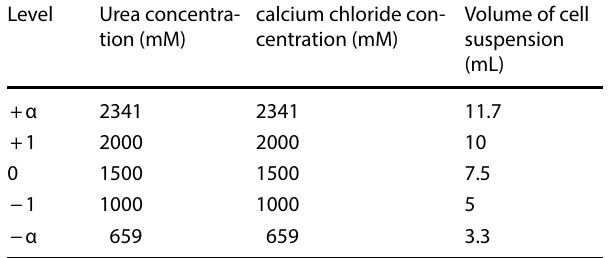
Table 2 Experimental range and levels of independent